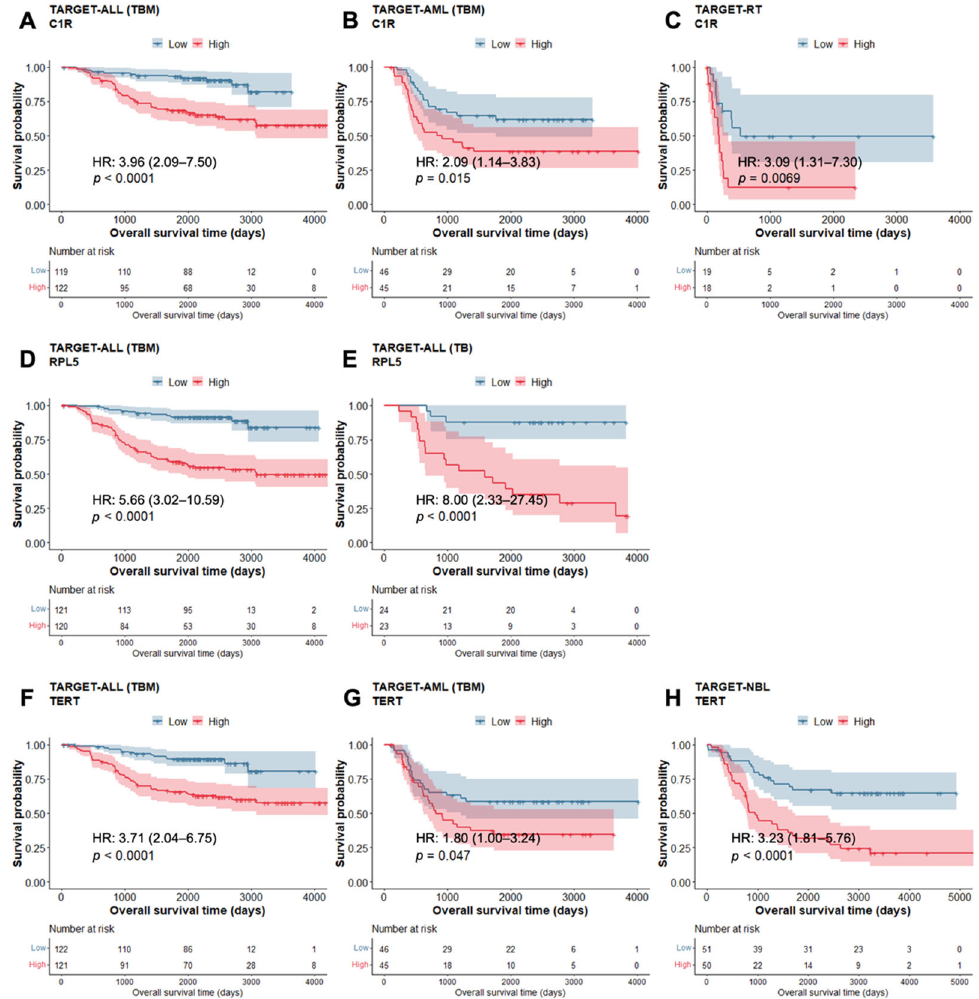
Figure 5. Kaplan–Meier survival curves for C1R : ( A ) ALL (TBM), ( B ) AML (TBM), and ( C ) RT, for RPL5 : ( D ) ALL (TBM), ( E ) ALL (TB), and for TERT : ( F ) ALL (TBM), ( G ) AML (TBM), and ( H ) NBL. Cox proportional hazard ratios (HR) and 95% CI are described. p -value is based on log-rank test and 95% CI is represented by the shaded region.